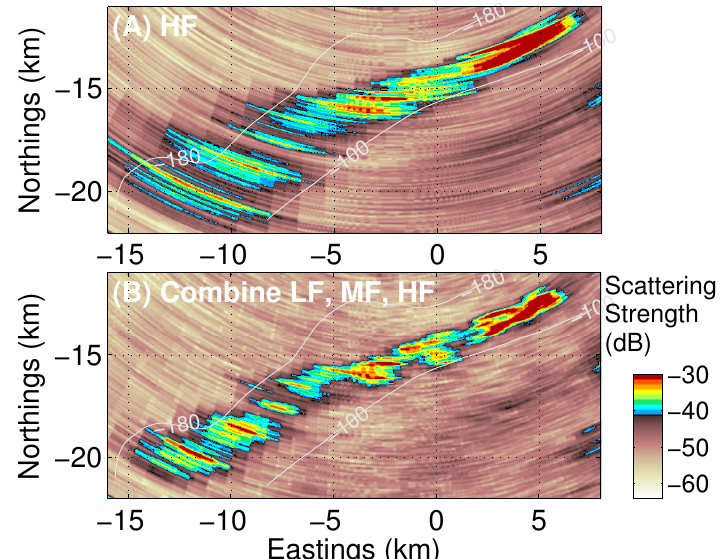
Figure 6. The same as Figure 5 showing a comparison of instantaneous wide-area OAWRS scattering strength images of a spawning Atlantic herring shoal measured on 29 September 2006 on the northern flank of Georges Bank. These images are formed from an LFM pulse transmission of 1 s duration and 50 Hz bandwidth centered at 1125 Hz (compare with Figure 4C in Ref. [2] based on an LFM pulse transmission centered at 950 Hz). Acoustic data are beamformed in time domain using ( A ) the conventional uniformly-spaced HF subaperture and ( B ) the newly defined nonuniformly-spaced subarray combining LF, MF, and HF